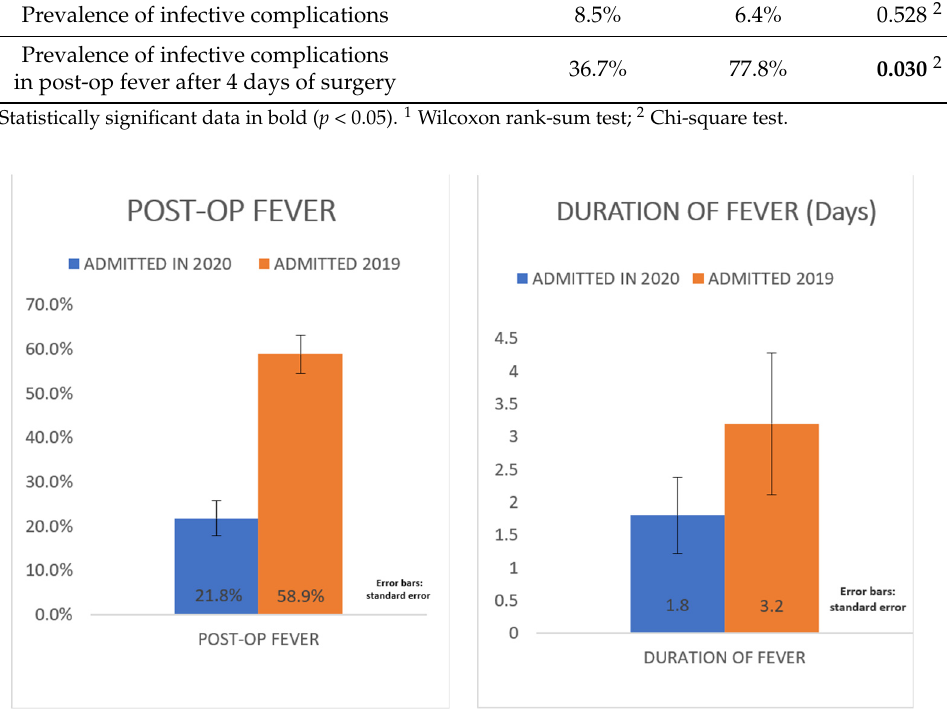
Figure 1. Difference between presence of post-op fever and post-op duration of fever in 2019 and in 2020.